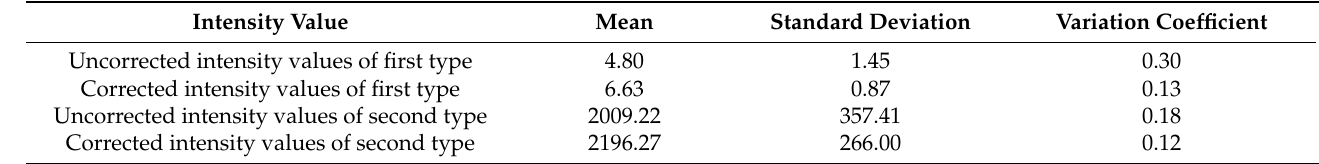
Figure 11. Results for strip 2: ( a ) the original intensity values (the reflectance); ( b ) the corrected intensity values by eliminating the effects of incident angle. Table 3. Intensity of mean, standard deviation, and variation coefficient before and after correction in flight strip 2. Intensity Value Mean Standard